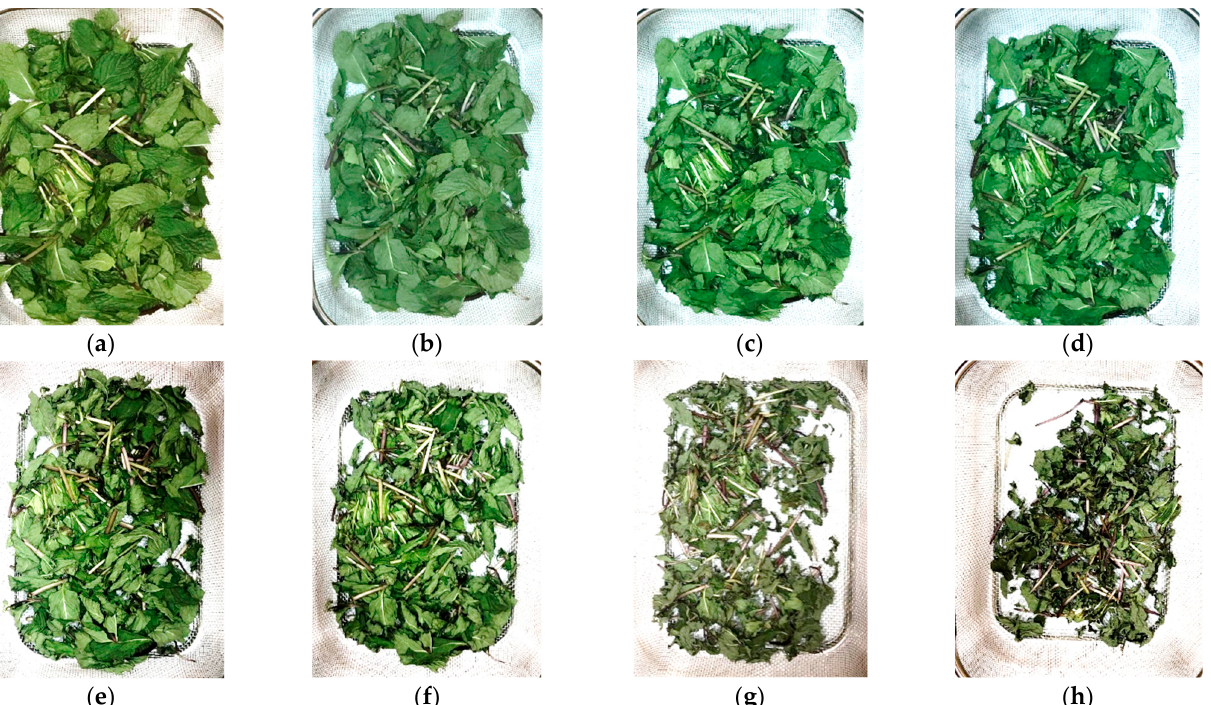
Figure 8. Basil DGCI degradation during different drying methods ( n = 3). The color parameter considered is an important factor that indicates the quality of the herbs. In this research, the indirect solar dryer shows good color retention capability in all selected herbs. Figure 9 presents visuals of mint color degradation during the drying process.